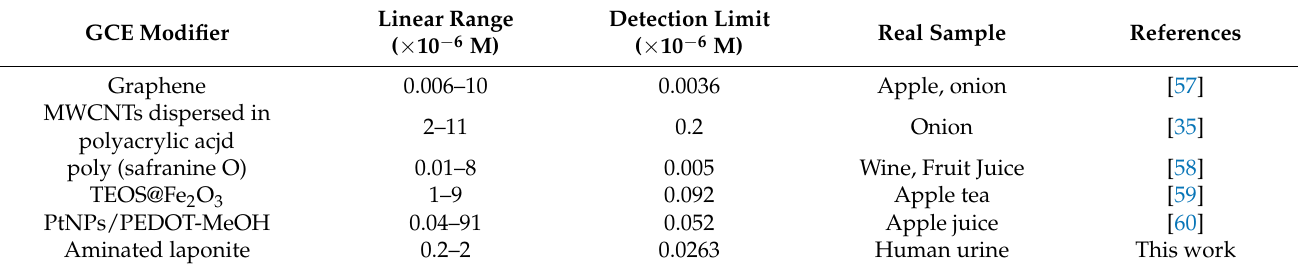
Table 1. Comparison of the performances of the LaNH 3+ /GCE sensor with those of other GCE- modified electrodes applied to the electroanalysis of quercetin.